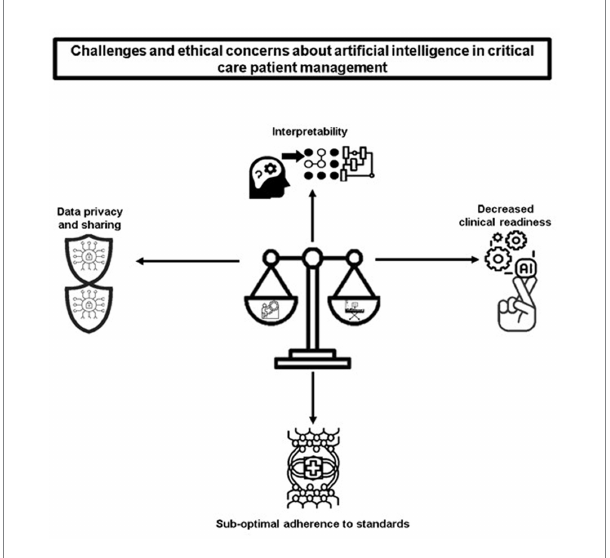
FIGURE 2 Challenges and ethical concerns of AI in critical care patient